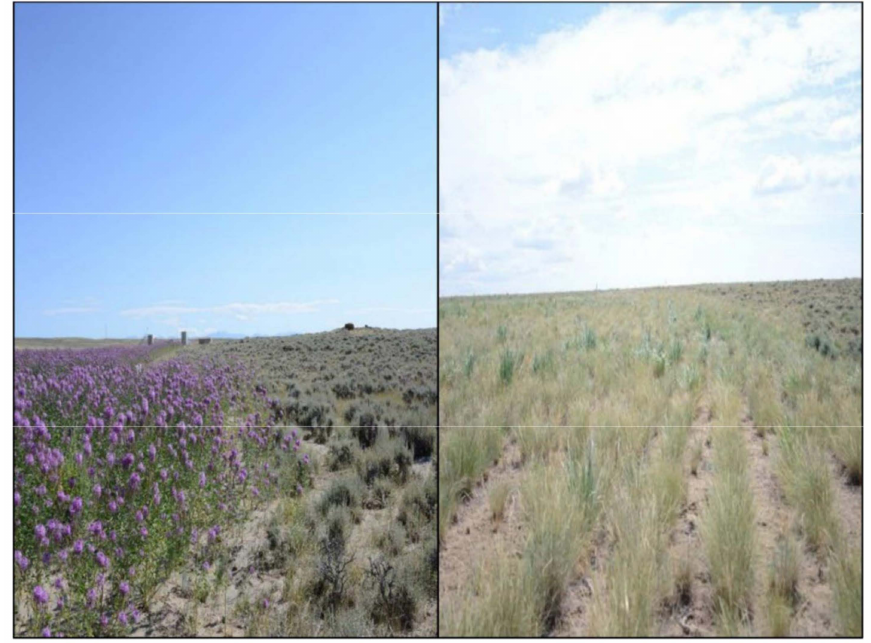
Figure 2. The left image shows the edge of a reclaimed well pad with mass flowering Rocky Mountain bee plant near the reference site, consisting primarily of Wyoming big sagebrush. The right image shows the edge of a reclaimed well pad consisting primarily of native, perennial grasses with the Wyoming big sagebrush reference system in the